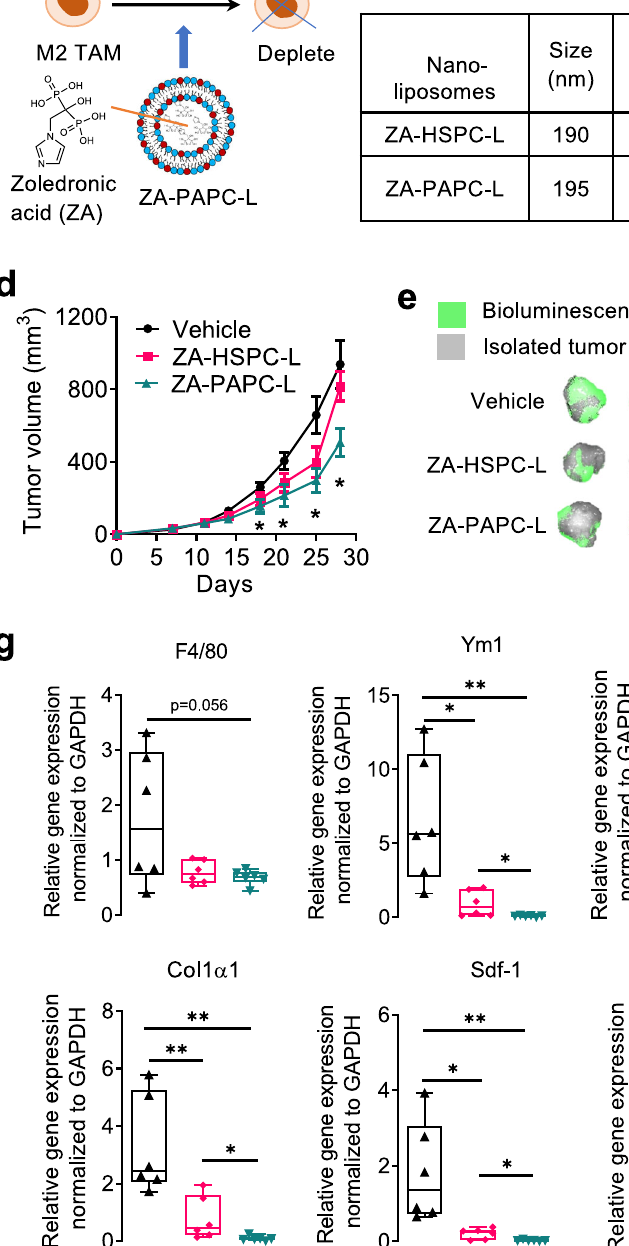
Statistical analysis was performed with unpaired two-tailed Student ’ s t -test. e Representative images showing the isolated tumors with bioluminescence signal (green). f Graphs showing the tumor weight of the isolated tumors at the end of the experiment. N =6 mice per group (* p =0.043). Statistical analysis was performed with unpaired two-tailed Student ’ s t -test. g Box graphs showing quantitativereal-timePCRresultsshowing theeffect of ZA-HSPC-Land ZA-PAPC- Londifferentmarkersforpre-metastaticnicheinlungs. N =6micepergroup(left to right, Ym1: * p =0.010, ** p =0.0043, * p =0.044; Ccr2: * p =0.018, * p =0.042; Postn: ** p =0.0020, ** p =0.0031, * p =0.021; Col1 α 1: ** p =0.0088, ** p =0.0011, * p =0.048; Sdf-1: * p =0.014, ** p =0.0079, * p =0.012; iNos: ns = non-signi fi cant). Datain( f and g )representthebox-and-whiskerplotinwhicheverydotrepresents a data point and the line in the box as median; the box shows the upper to the lower quartiles; the whiskers show the minimum to the maximum value. Statis- tical analysis was performed with unpaired two-tailed Student ’ s t-test. Source data are provided as a Source Data fi